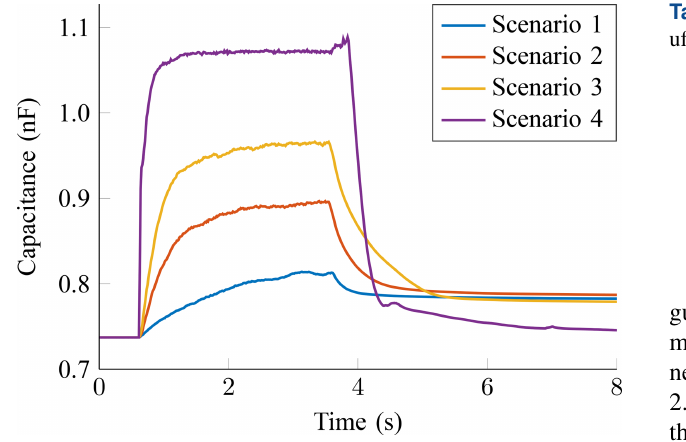
Figure 7. Experimental results of capacitance against time for real- istic road surface scenarios.